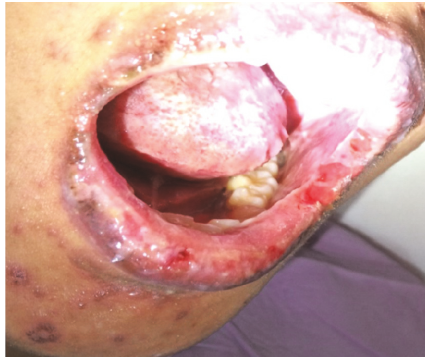
Figure 1: Clinical photograph showing multiple ulceration in the mouth, crusting of the lips, and vesicles and papules of the skin. episodes of dizziness, nausea and constipation following the new